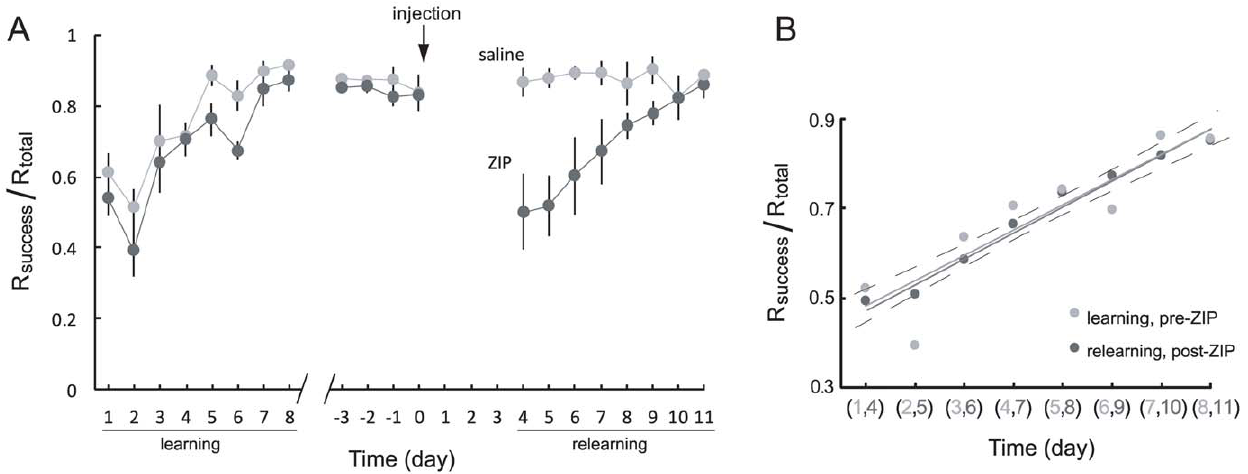
Figure 2. Effects on task performance of ZIP and saline injections into the sensorimotor cortex. A) ZIP, but not saline injection disrupts the retention of sensorimotor memory. Successful reaches/total reaches (R success /R total ) for the initial learning period of 8 days, the 4 days preinjection (days 2 3 to 0), and, after a delay, the 8 days postinjection (days 4 to 11, with 0 the day of injection). Means 6 SEM; 5 animals per group. B) Linear regressions of learning and relearning curves (pre-ZIP, grey solid line; post-ZIP, black solid line). The 95% confidence interval of the pre-ZIP regression (dashed curves) envelopes the post-ZIP regression line.